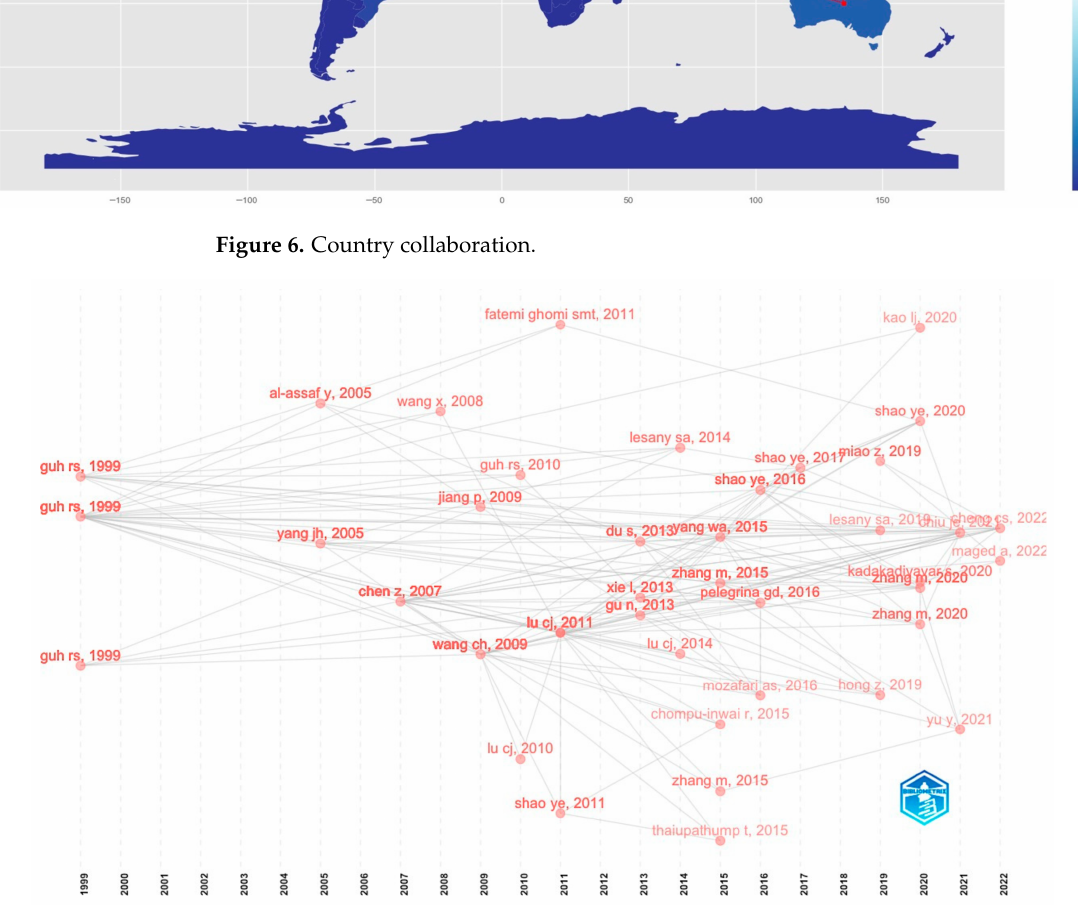
Figure 7. Historical direct citation